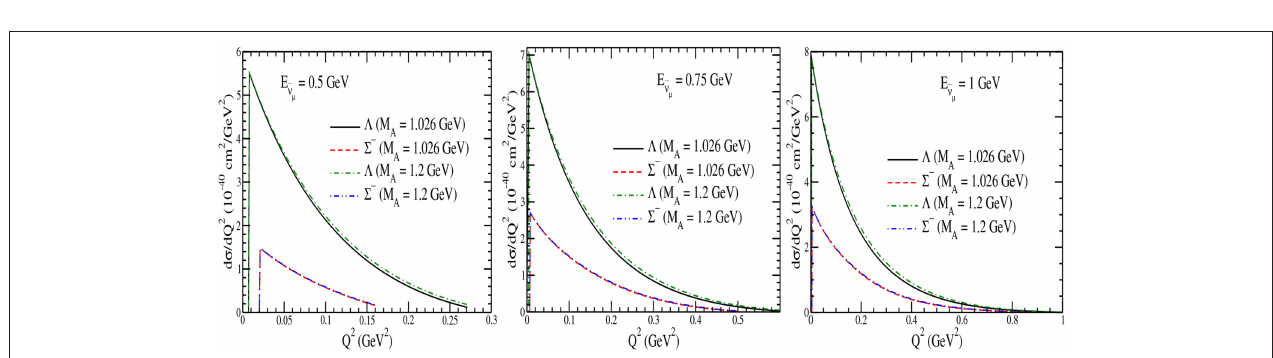
FIGURE 4 | d σ/ dQ 2 vs. Q 2 for the hyperon production cross sections at different antineutrino energies viz. E GeV (right) . Lines and points have the same meaning as in Figure 3 .